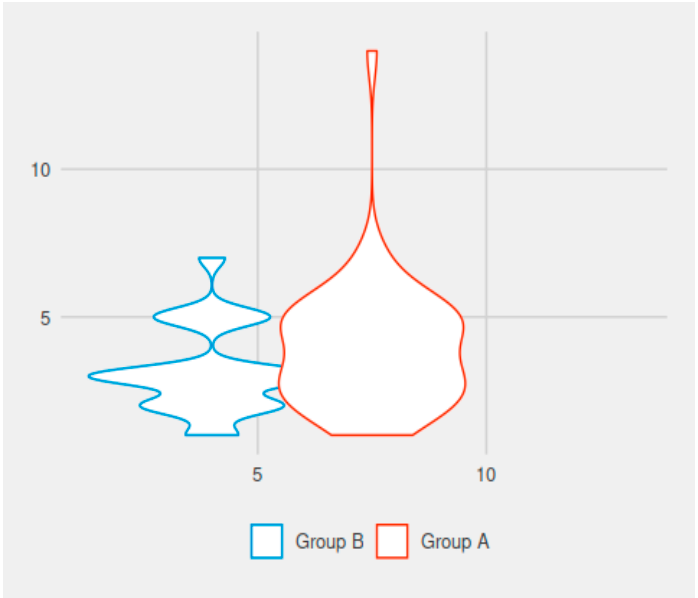
Figure 1. Duration of postoperative pain versus duration of antialgic administration with or without electrocautery use (on the vertical line—the duration of postoperative pain in the two groups of children, in days; on the horizontal line—the duration of painkiller medication need in the two groups of enrolled children, in days).